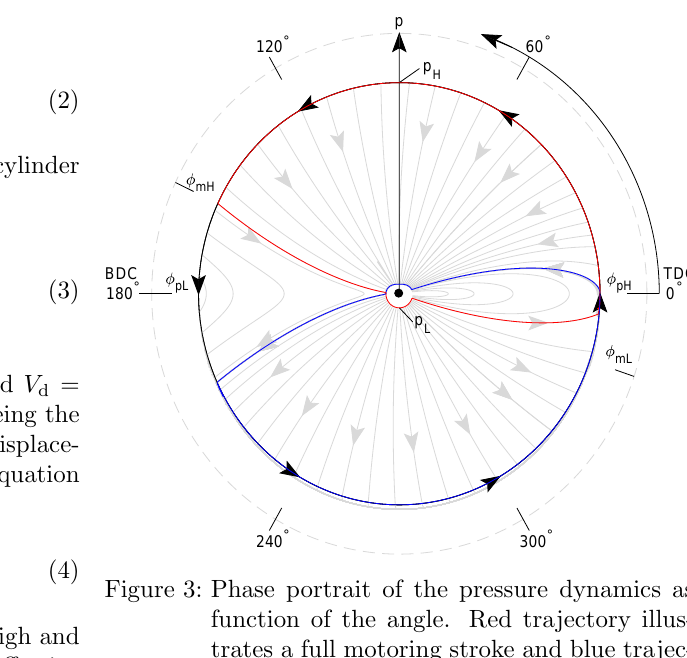
Figure 3: Phase portrait of the pressure dynamics as function of the angle. Red trajectory illus- trates a full motoring stroke and blue trajec- tory illustrates a full pumping